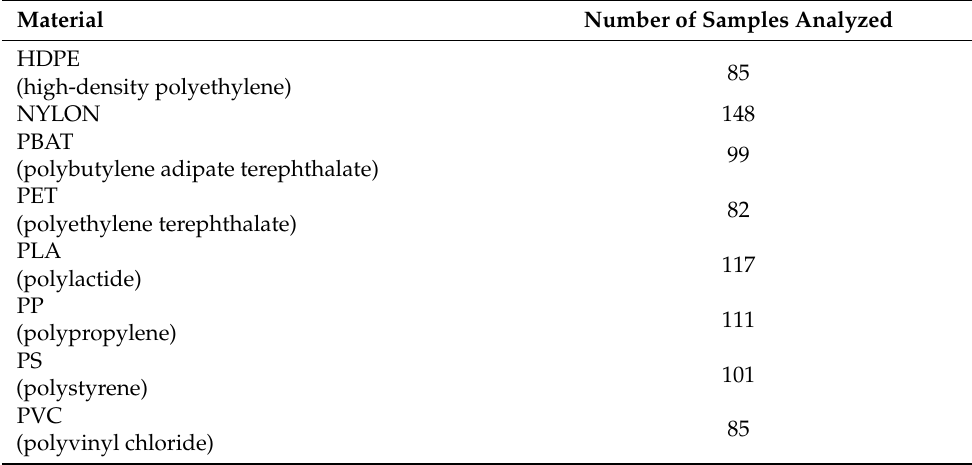
Table 1. Materials and corresponding number of samples analysed by